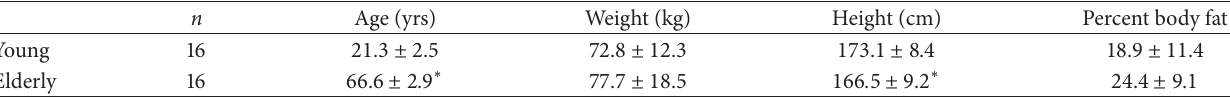
Table 1: Participants characteristics.